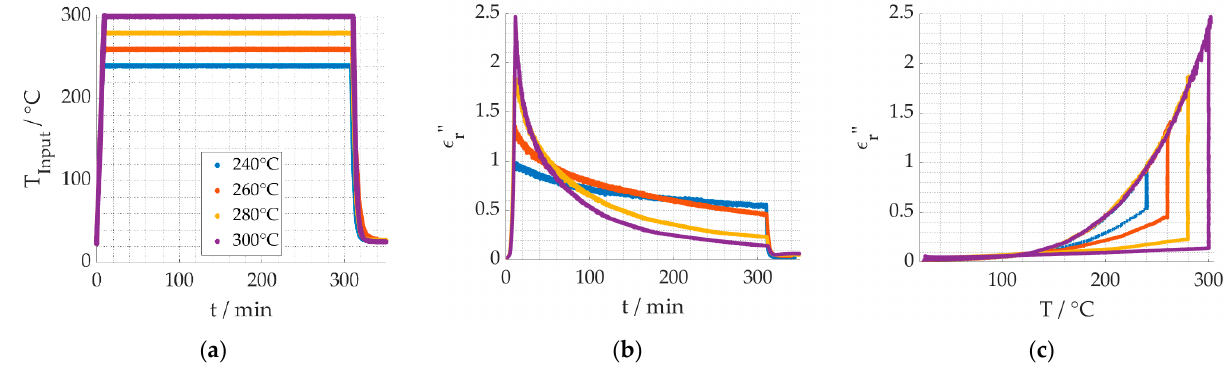
Figure 7. Dielectric loss long term measurement for different temperatures. ( a ) Temperature profiles. ( b ) Dielectric loss over time. ( c ) Dielectric loss over temperature.